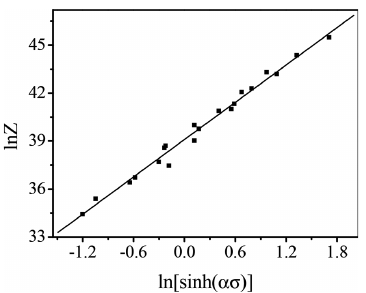
Figure 4: Relationship between ln Z and ln sinh ασ ð Þ½ (cid:2) .